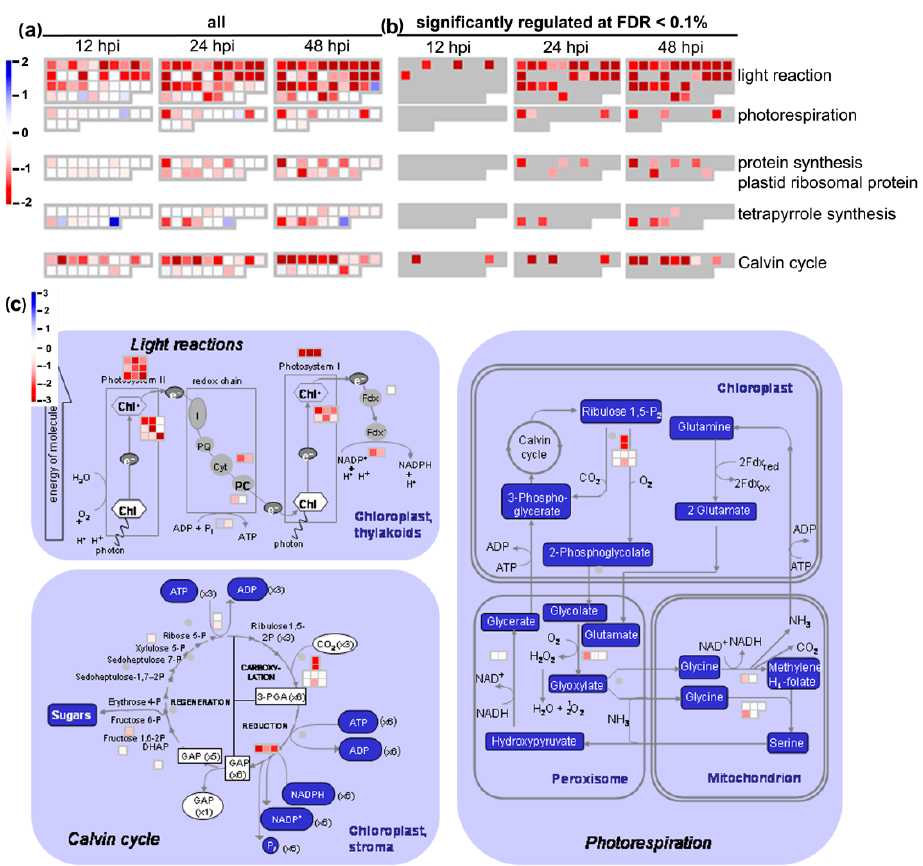
Figure 8. Microarray-based analysis of expression changes of photosynthesis-related B. oleracea genes during the course of A. brassicicola infection. ( a ) MapMan analysis of all mapped photosynthesis-related genes (104 genes); ( b ) MapMan analysis of photosynthesis-related genes significantly regulated at FDR < 0.1; ( c ) MapMan diagram of significant expression changes of photosynthesis-related genes at 48 hpi.